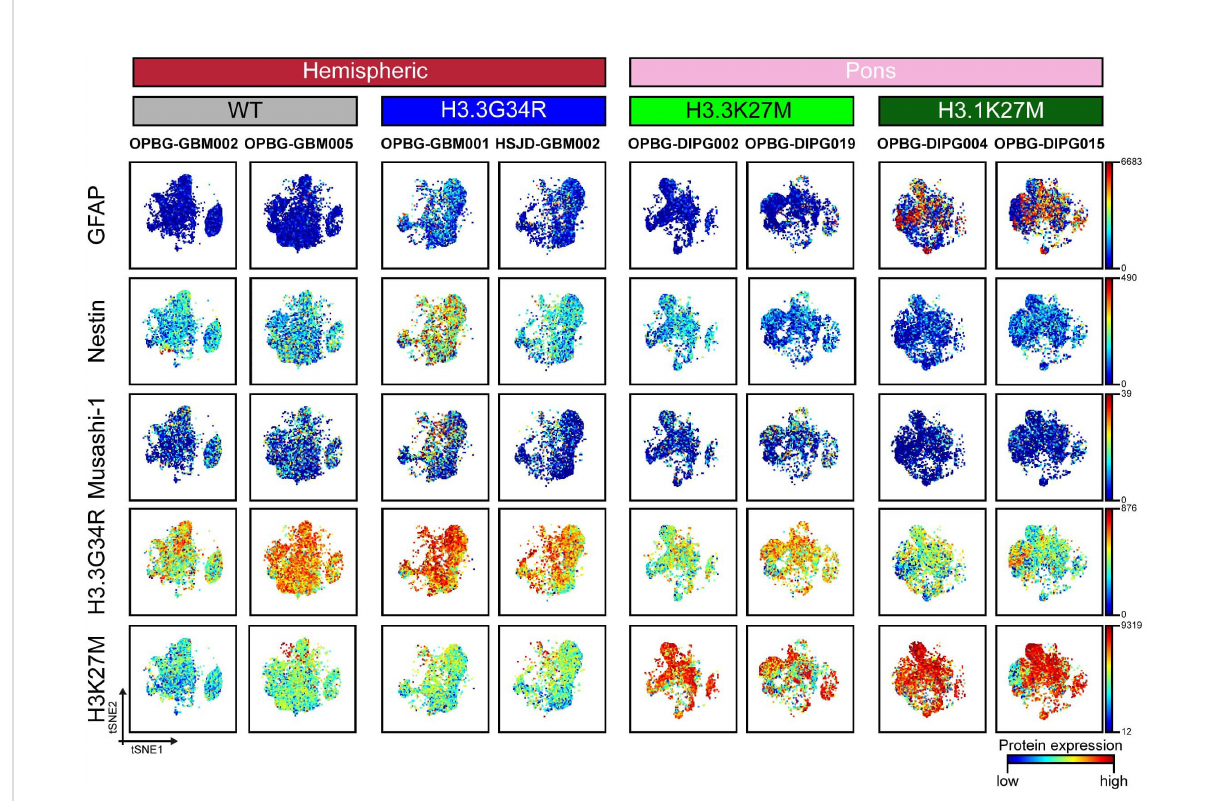
FIGURE 3 CyTOF single-cell analysis of intracellular antigen in PDHGG patient-derived cell lines. t-SNE maps showing the expression of 5 intracellular markers (GFAP, Nestin, Musashi-1, H3.3G34R and H3K27M) in each of the eight different PDHGG patient-derived cell lines analyzed through the mass cytometry technique. The color gradient refers to the intensity of the expression of the considered marker, in a blue to red scale indicating low and high intensity